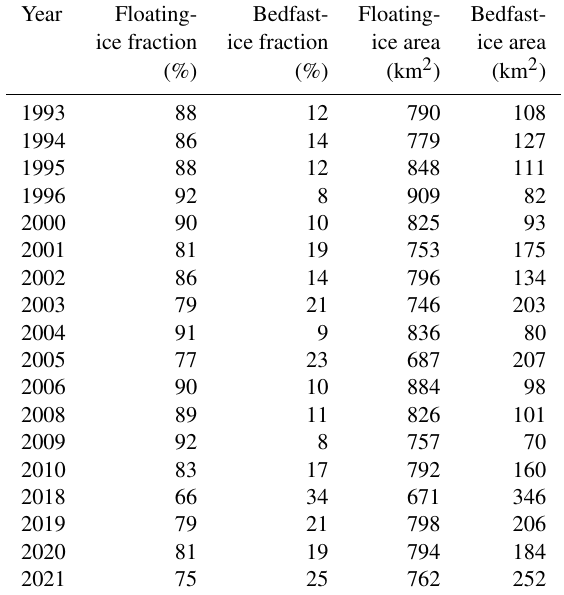
Table 5. Bedfast and floating lake ice fractions and area (km 2 ) in the OCF from 1992/1993 to 2020/2021. A lake mask created using the 2020/2021 lake extent was used to extract lake ice